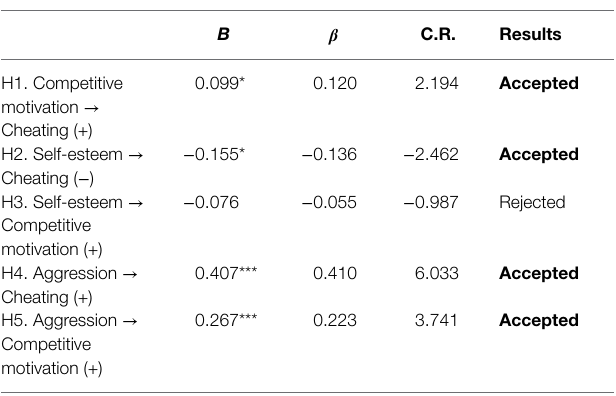
TABLE 3 | Hypothesis test results. B β